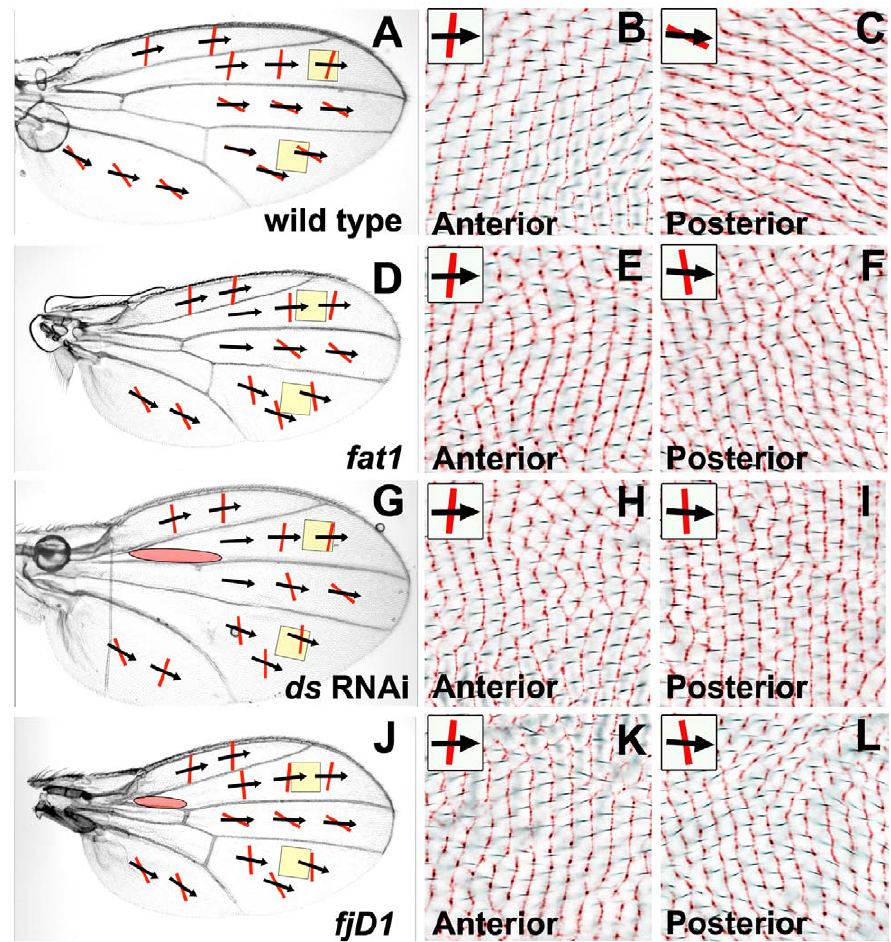
Figure 3. Reduced Ft/Ds pathway gene activity alters posterior ridge orientation without affecting hair polarity. All micrographs are of the female dorsal wing surface. Black arrows indicate local hair polarity; red lines indicate local ridge orientation. Panels B, C, E, F, H, I, K and L show light micrographs of hair polarity overlaid on an inverted and colorized (red) CRM image of ridge orientation in the same region. (A) Wild-type (Canton S) wing. (B) Detail of anterior wild-type wing (anterior yellow shaded region in (A)). (C) Detail of posterior wild-type wing (posterior yellow shaded region in (A)). (D) ft 1 homozygous wing. (E) Detail of anterior ft 1 homozygous wing (anterior yellow shaded region in (D)). (F) Detail of posterior ft 1 homozygous wing (posterior yellow shaded region in (D)). (G) MS109-Gal4 ; UAS-ds(IR) wing. (H) Detail of anterior MS109-Gal4 ; UAS-ds(IR) wing (anterior yellow shaded region in (G)). (I) Detail of posterior MS109-Gal4 ; UAS-ds(IR) wing (posterior yellow shaded region in (G)). (J) fj D1 homozygous wing. (K) Detail of anterior fj D1 homozygous wing (anterior yellow shaded region in (J)). (L) Detail of posterior fj D1 homozygous wing (posterior yellow shaded region in (J)).